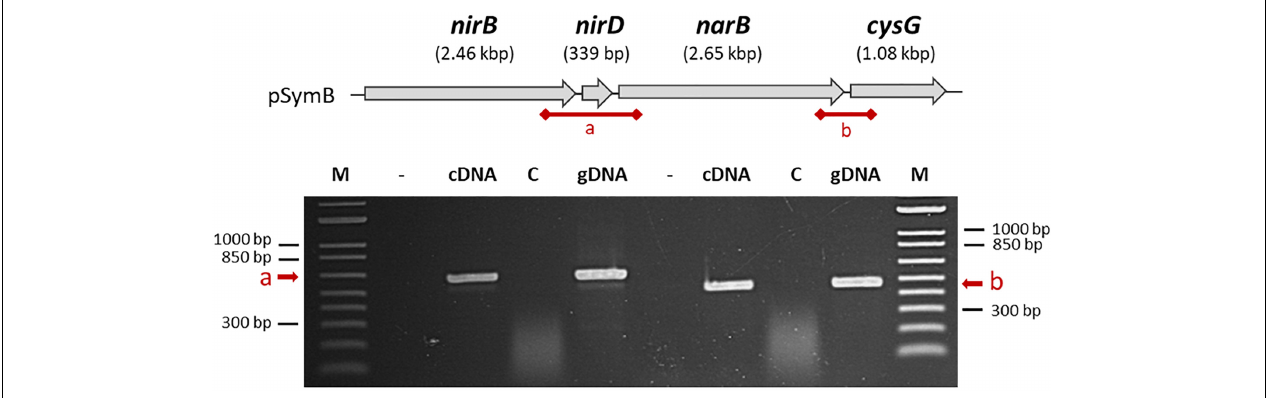
FIGURE 2 | Organization of nirB , nirD, and narB genes on the S. meliloti genome. nirB, nirD , narB, and cysG genes are located on the S. meliloti megaplasmid pSymB as indicated at the top of the figure. The putative intergenic regions which are tested by PCR in the bottom part of the Figure are called (a) and (b). Total RNA isolated from cells grown in aerobic conditions in VMM without NH 4 Cl in the presence of nitrate served as template for cDNA synthesis in the presence (cDNA) or in absence of reverse transcriptase enzyme (control, C). Genomic DNA was used as a positive control for PCR amplifications. The first lane (–) is a negative control without